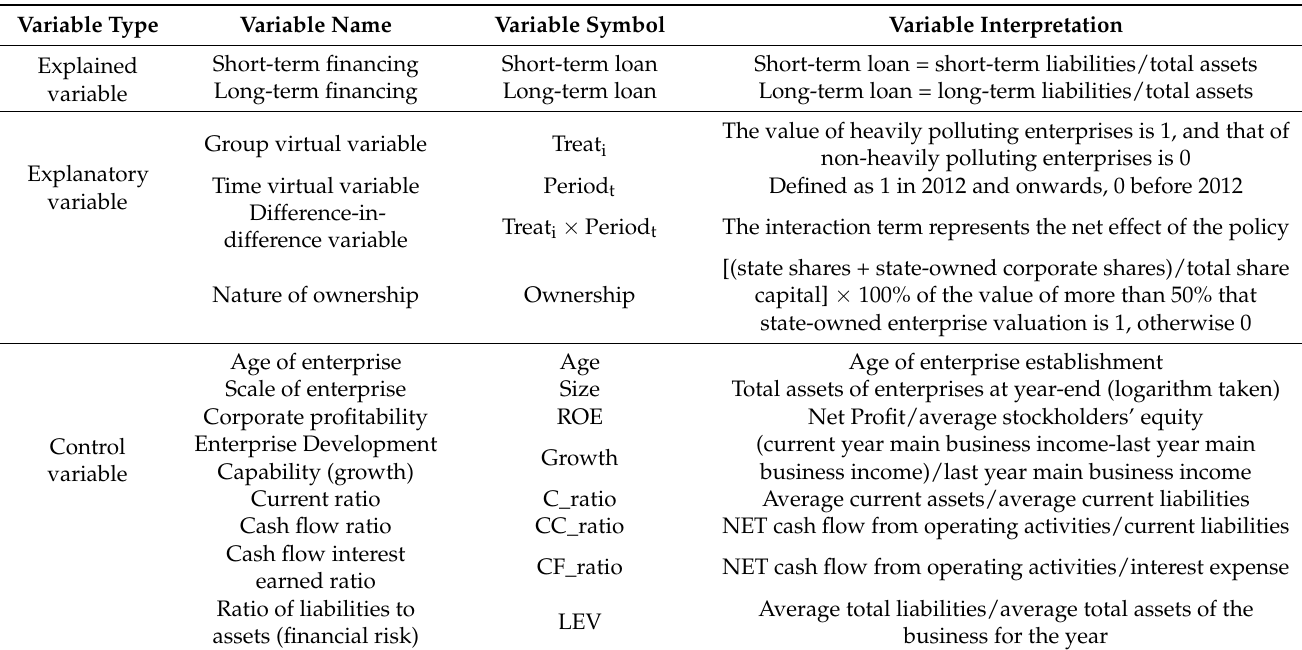
Table 1. Variable